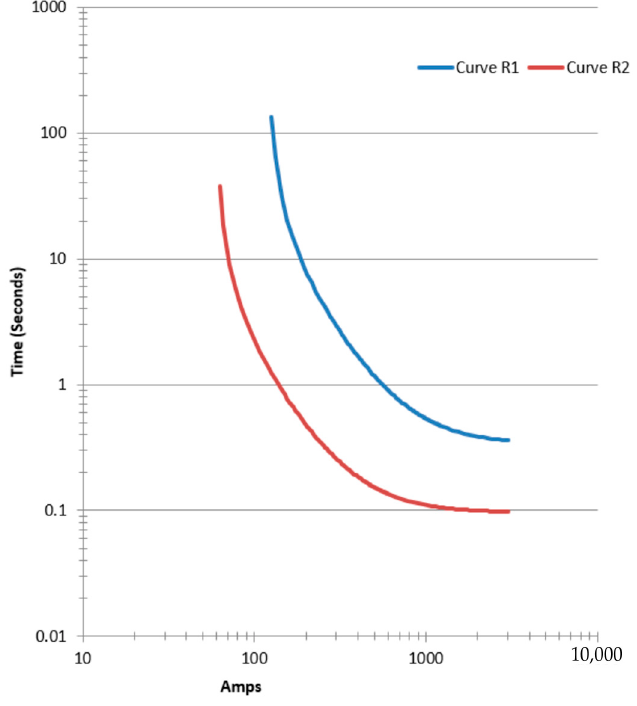
Figure 7. Relay operating time v/s Fault current for the inverse time scheme.